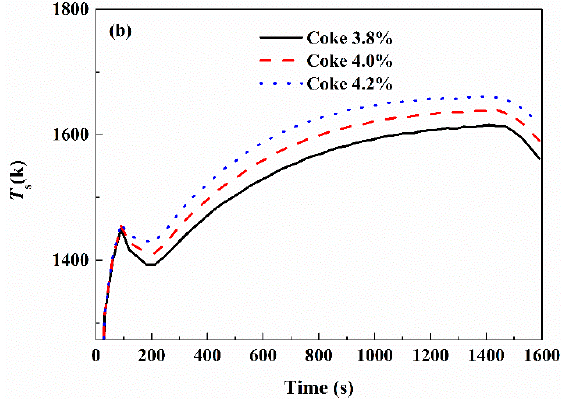
Figure 9. FFS and ST ( a ) and MaxT ( b ) with different coke ratios.